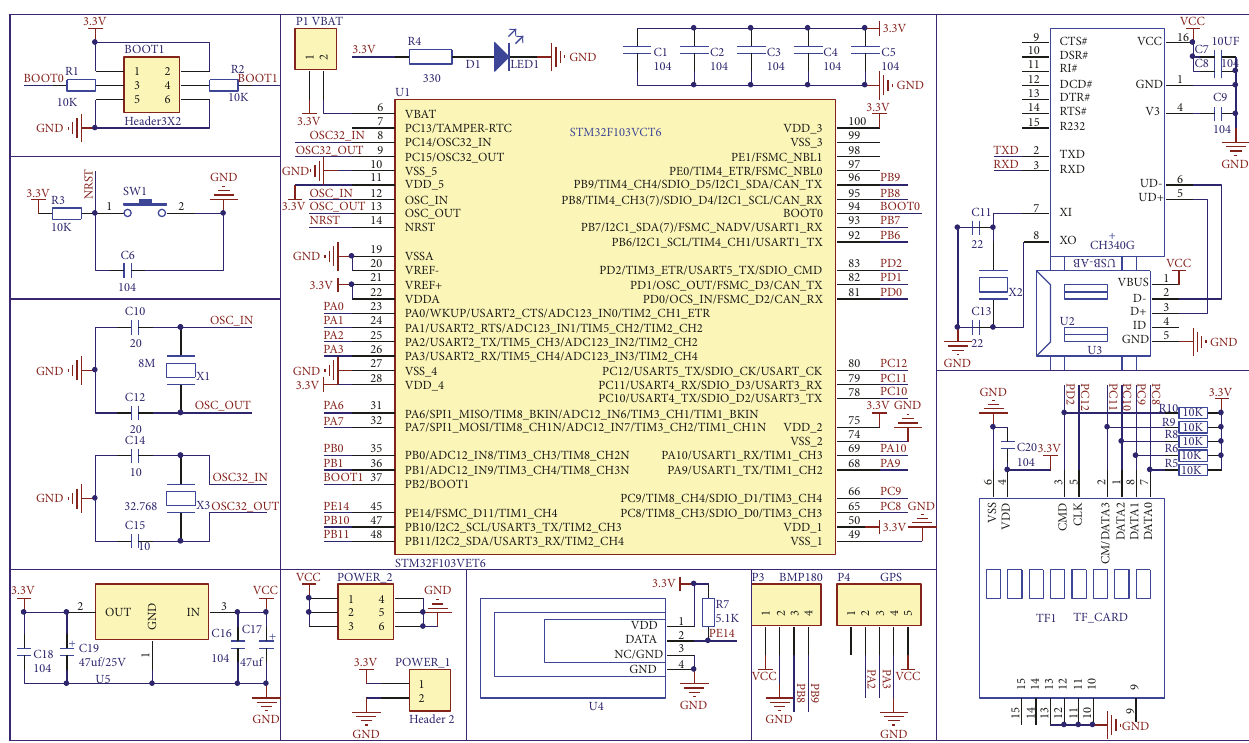
Figure 12: Detection system circuit.